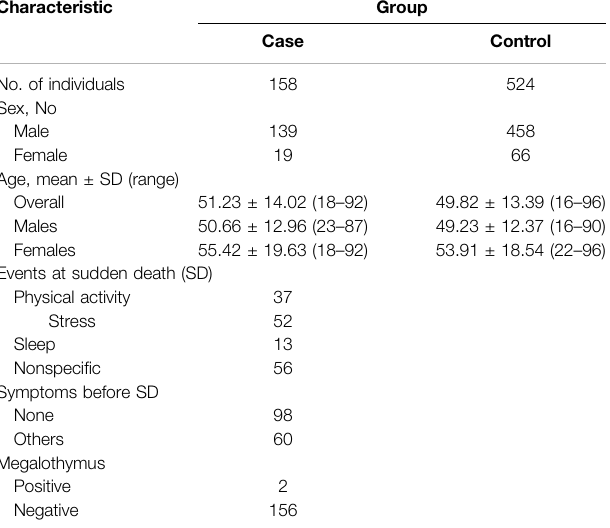
TABLE 1 | Clinical characteristics of SCD cases and